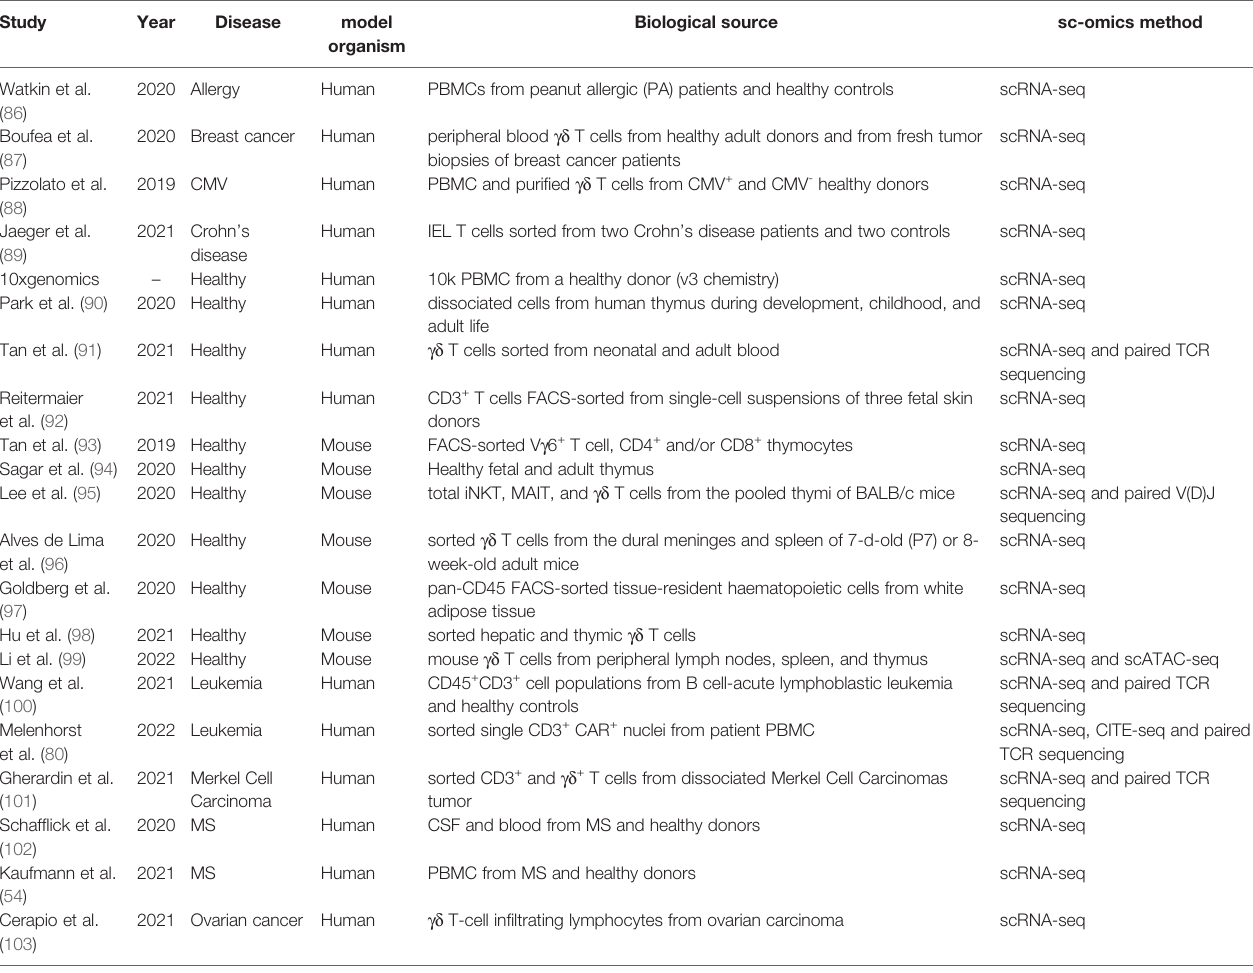
TABLE 1 | Summary of single-cell multi-omics datasets from healthy individuals or